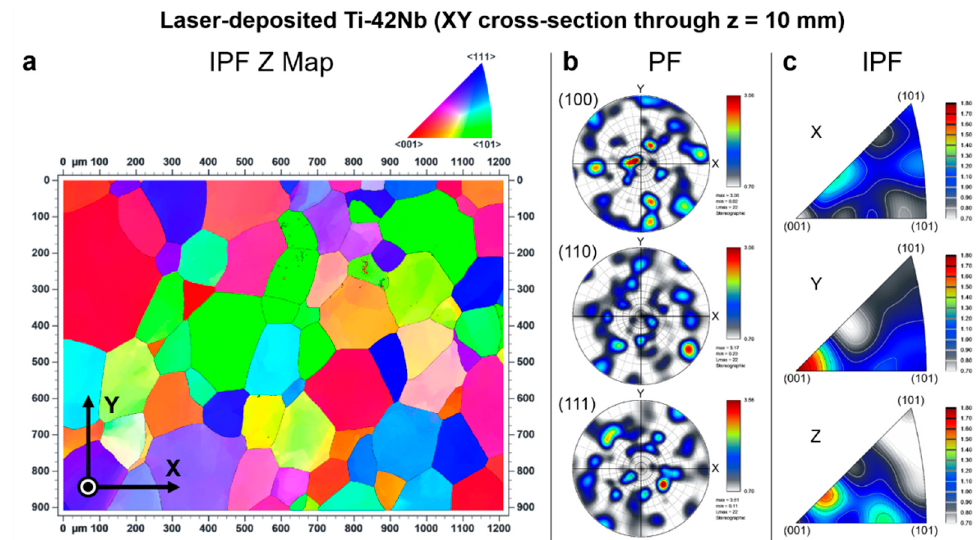
Figure 10. Electron backscatter diffraction (EBSD) results at XY cross-section through z = 10 mm: ( a ) inverse pole figure Z map (IPF Z Map), ( b ) pole figures (PF), and ( c ) inverse pole figures (IPF).